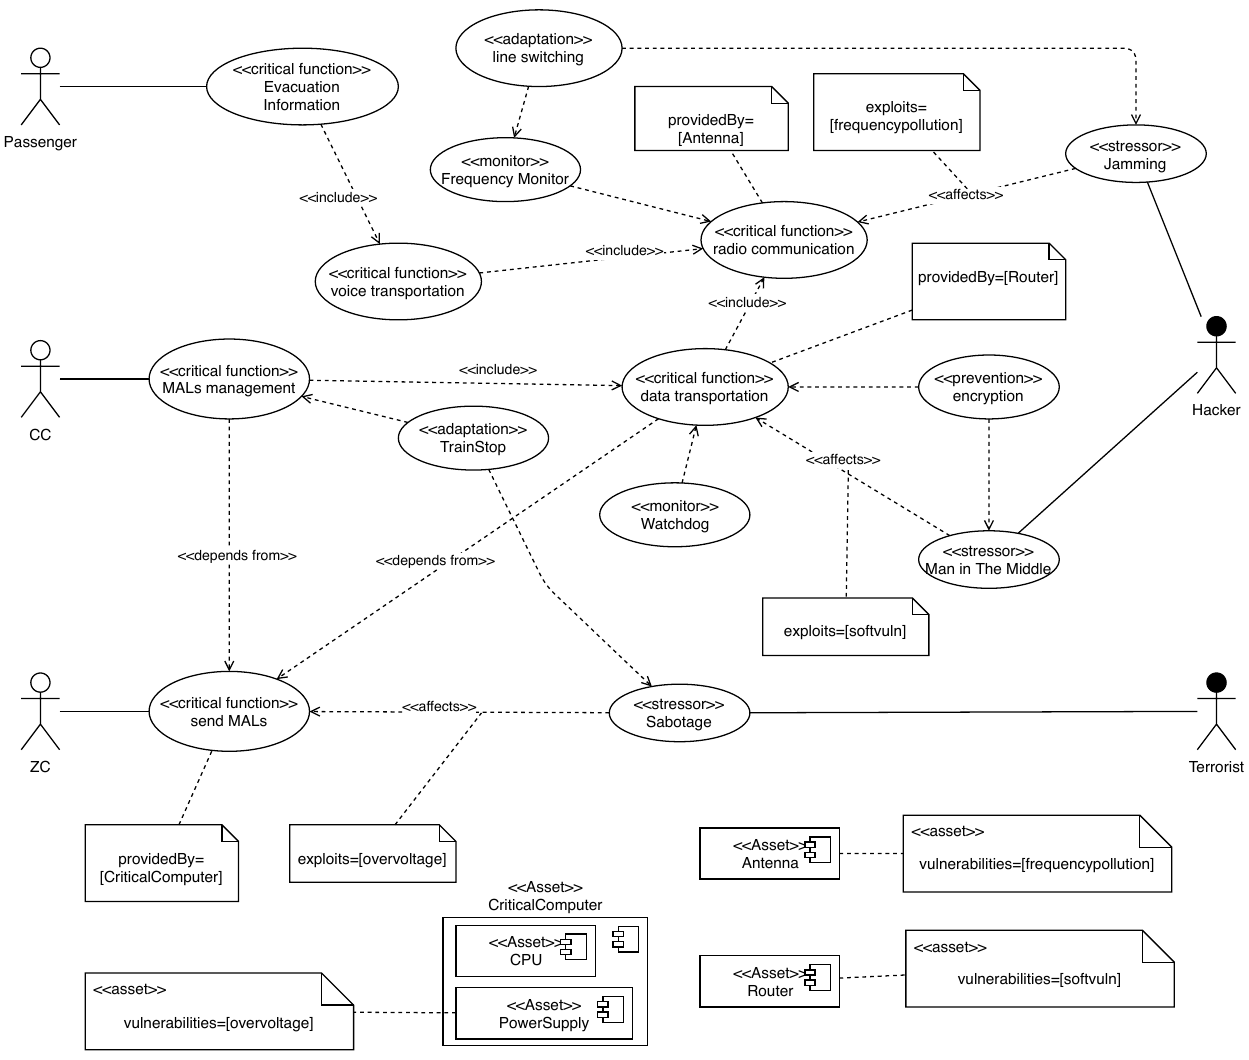
Figure 14. The annotated CT-UML model of the CTBC radio subsystem. Some of the critical functions are explicitly supported by “assets ”, as depicted in the small component diagrams in the